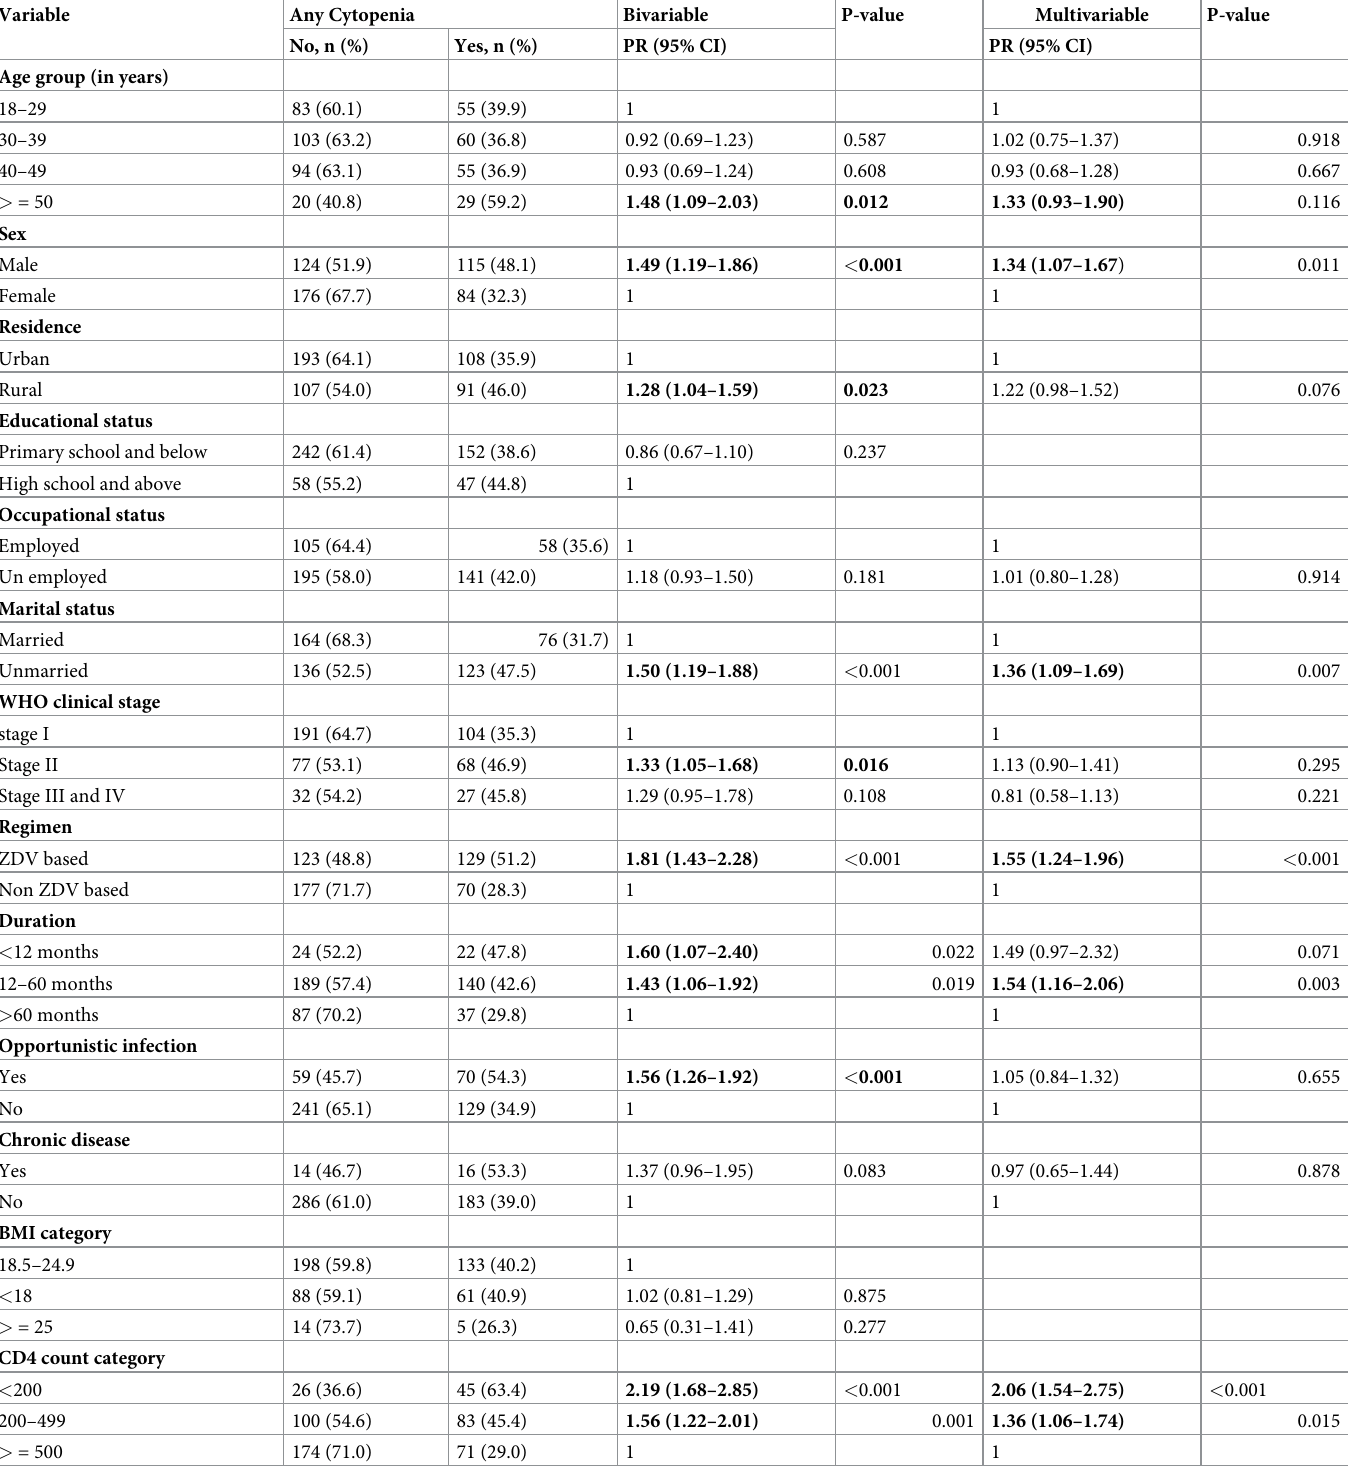
Table 4. Factors associated with cytopenia among HIV infected patients on HAART at Mahal-Meda Hospitals, Northern Shewa Zone, Ethiopia, 2018 (n = 499).